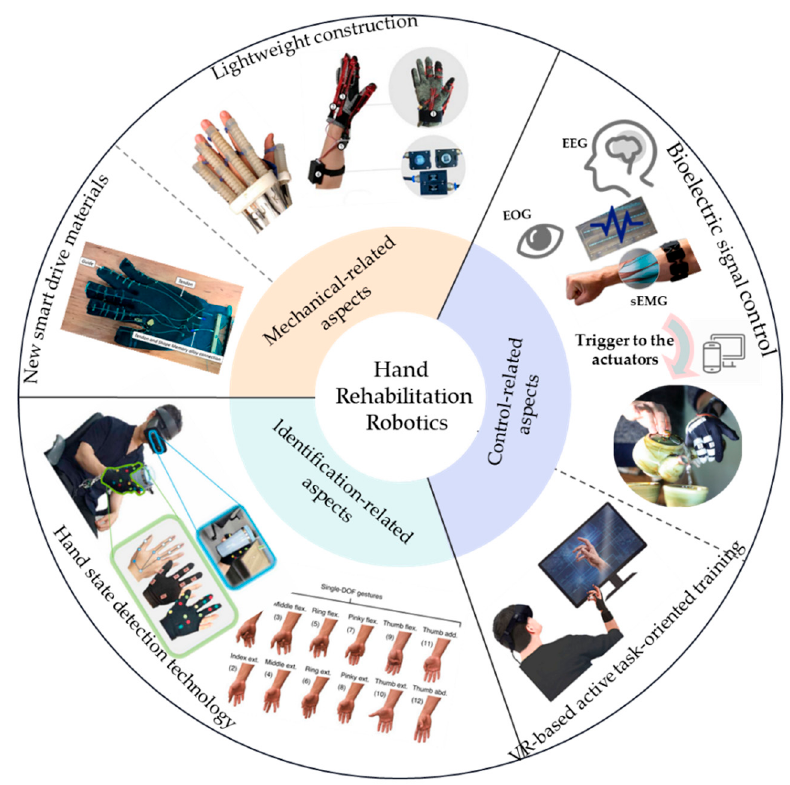
Figure 14. The conceptual figure of robotic solutions in post-stroke hand rehabilitation.